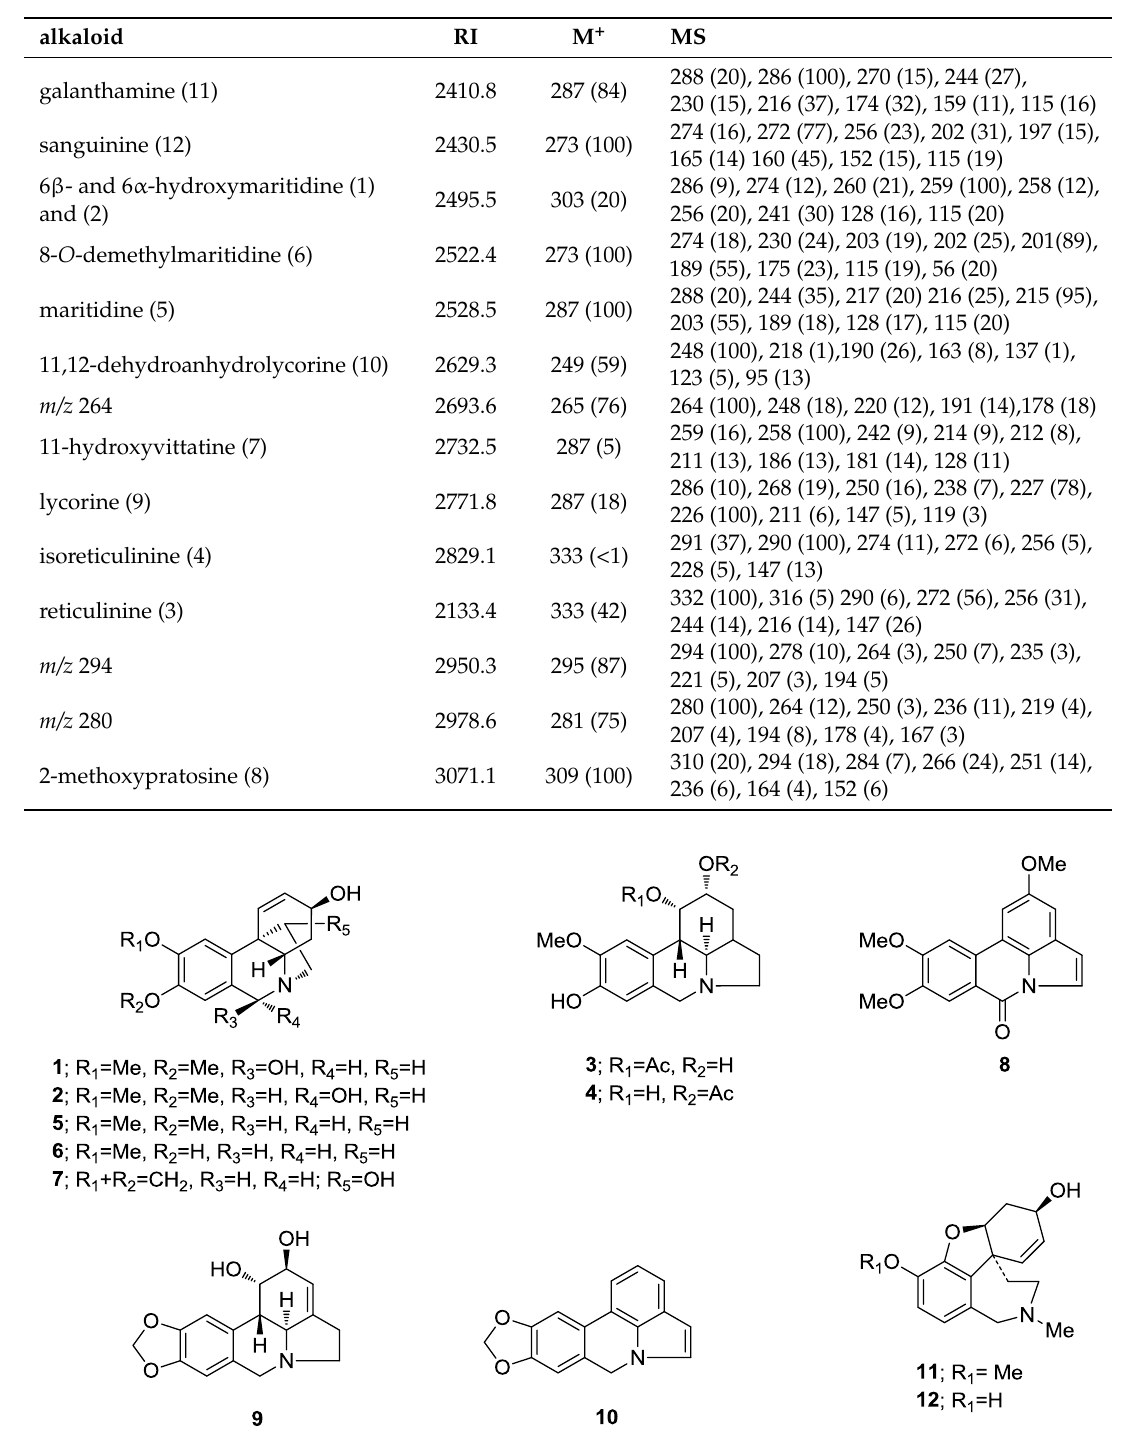
Table 1. Alkaloids identified in H. reticulatum by GC-MS.